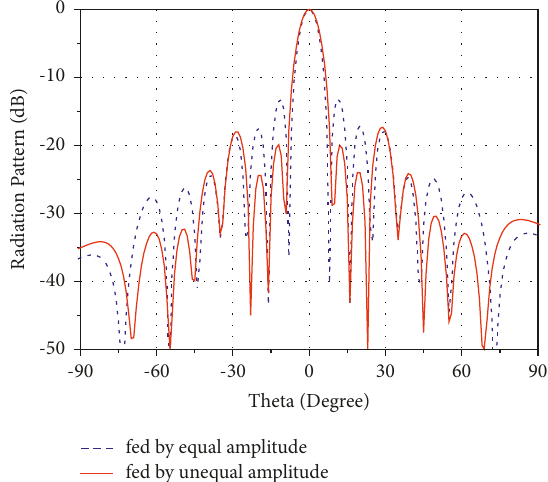
Figure 9: Radiation pattern of the antenna array fed by (a) equal amplitude (dash line) and (b) unequal amplitude (solid